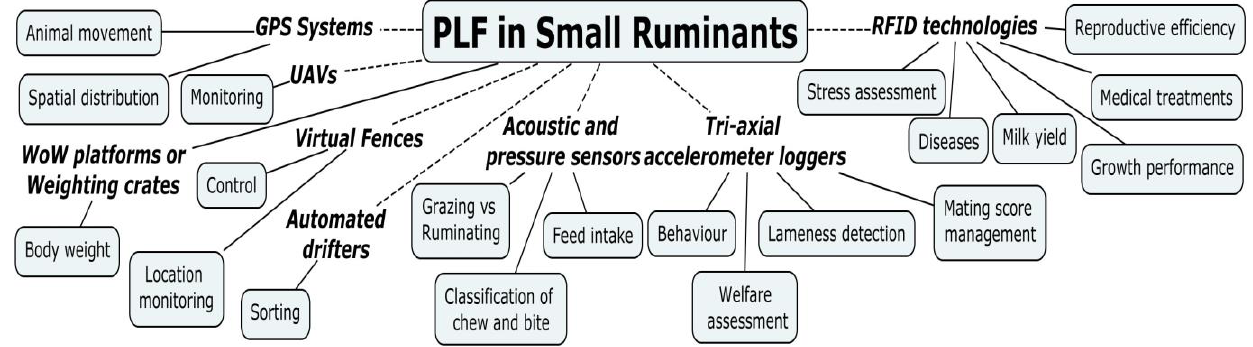
Figure 1. PLF applications in grazing sheep and